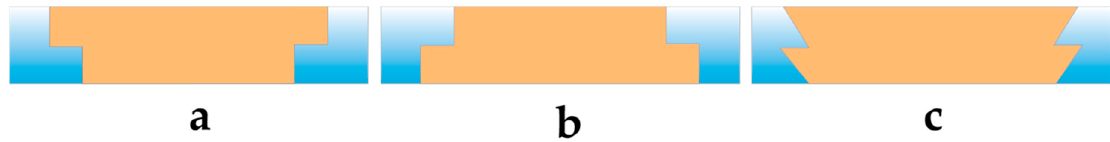
Figure 14. Sidecut profiles: ( a ) mushroom, ( b ) top hat, ( c ) zig-zag.